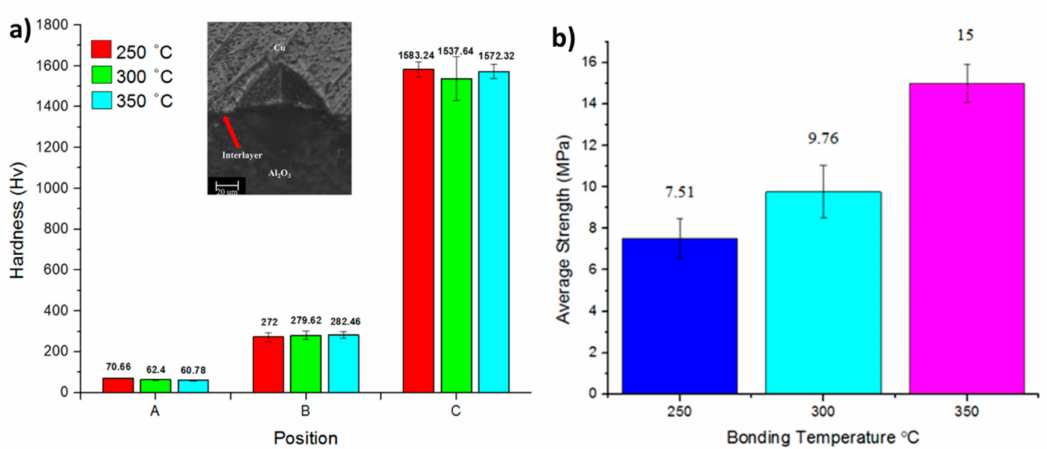
Figure 5. The ( a ) hardness at different areas, and ( b ) the tensile strength of the heterogeneous diffusion bondings of the alumina substrate and copper substrate for three different process temperatures, 250, 300, and 350 ◦